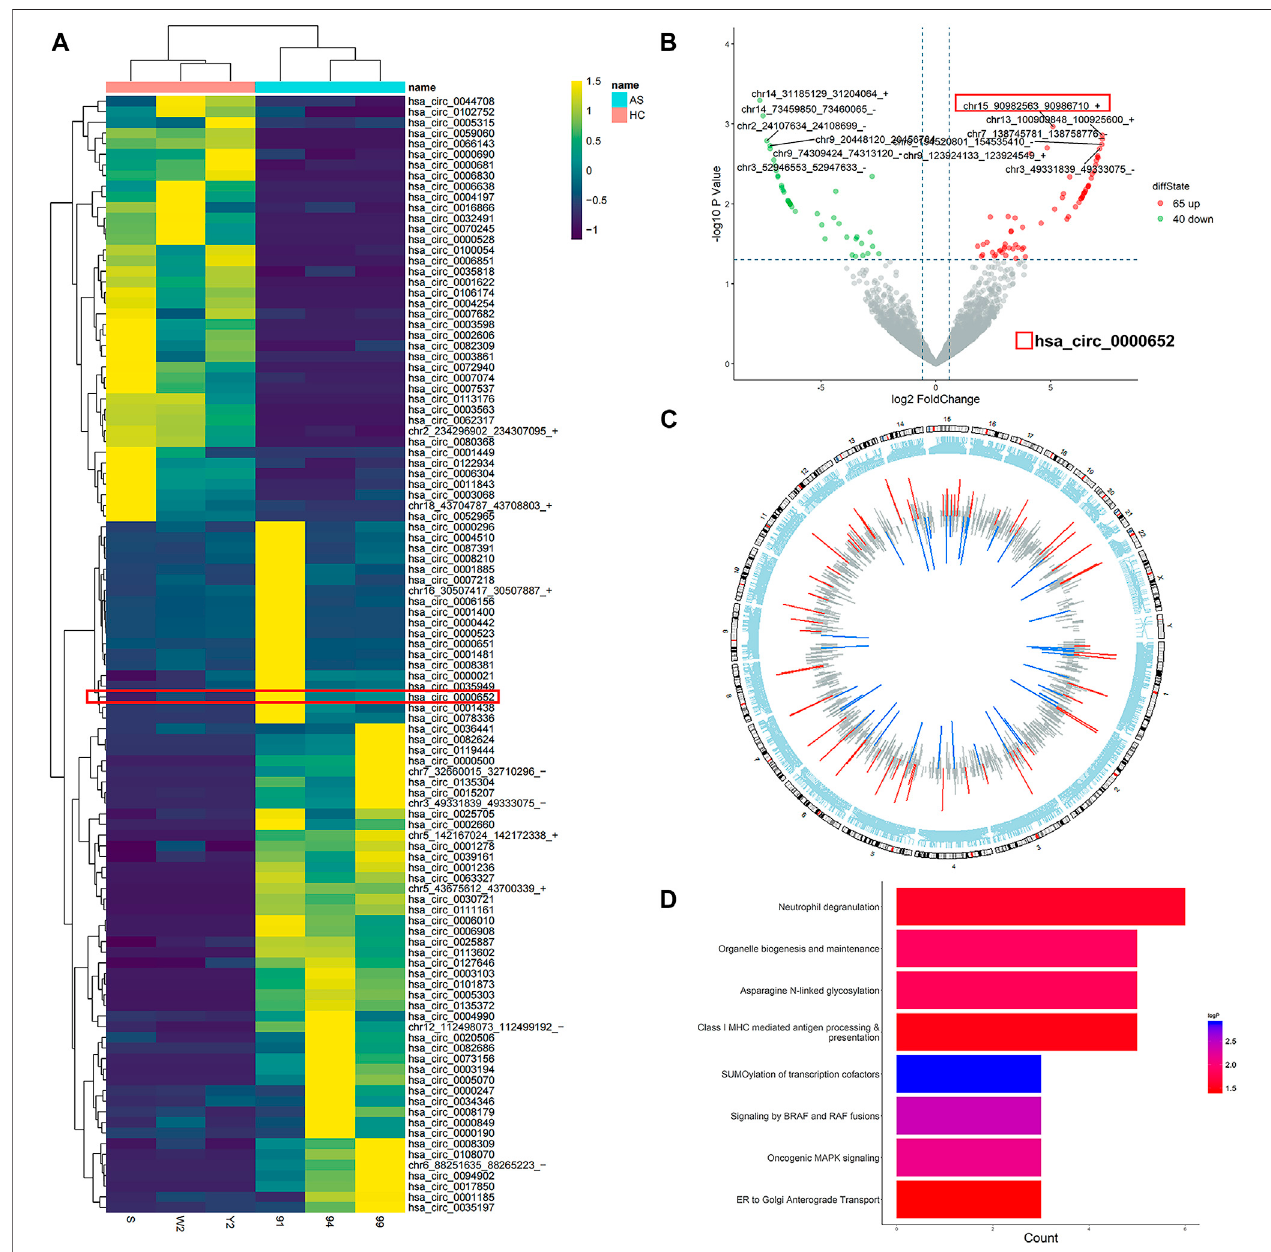
FIGURE1| CharacteristicsofdifferentiallyexpressedcircRNAsinPBMCsfromASpatients. (A) HeatmapofalldifferentiallyexpressedcircRNAsinPBMCsfromAS patients; (B) volcano scatter plot of differentially expressed circRNAs in PBMCs from AS patients; (C) chromosome distribution of differentially expressed circRNAs in PBMCs from AS patients; (D) reactome enrichment dot plot of the host genes of differentially expressed circRNAs in PBMCs from AS patients.